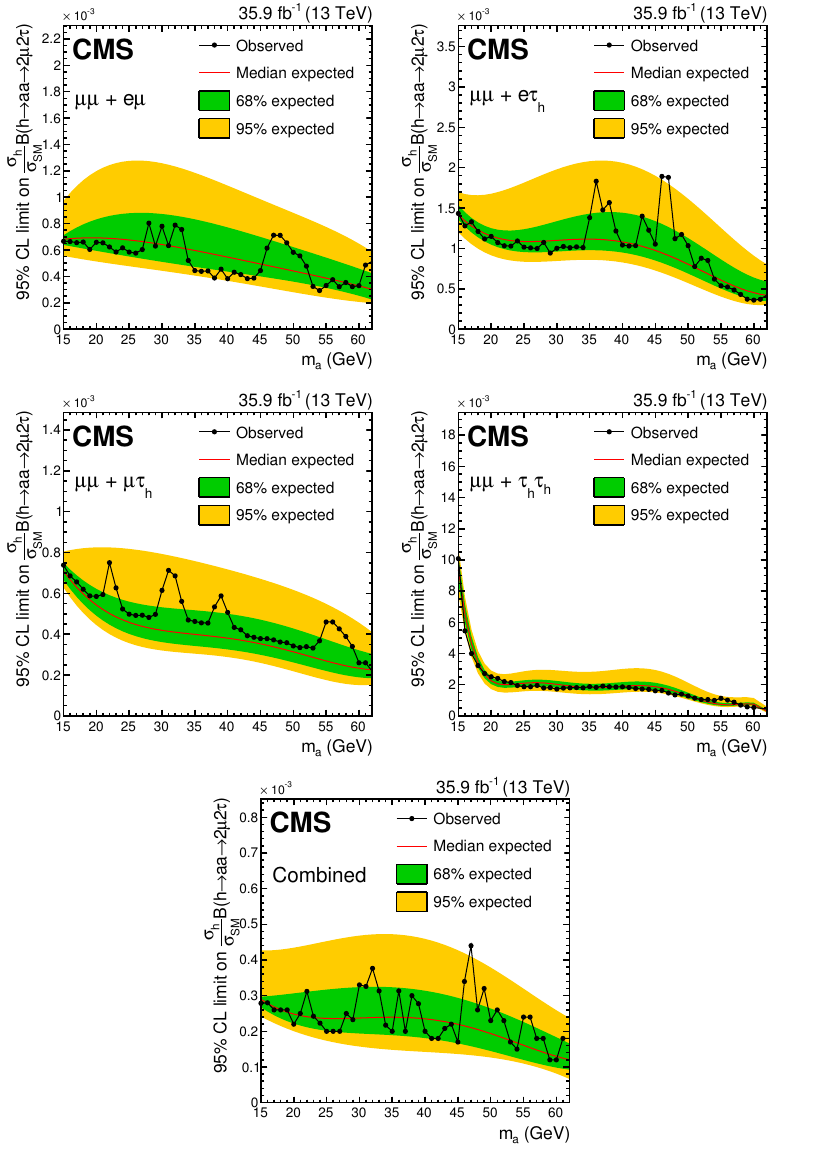
Figure 4 . Upper limits at 95% CL on ( (cid:27) h =(cid:27) SM ) B (h ! aa ! 2 (cid:22) 2 (cid:28) ), in the (cid:22)(cid:22) + e (cid:22) (upper left), (cid:22)(cid:22) + e (cid:28) h (upper right), (cid:22)(cid:22) + (cid:22)(cid:28) h (middle left), (cid:22)(cid:22) + (cid:28) h (cid:28) h (middle right) (cid:12)nal states, and for the combination of these (cid:12)nal states (lower). The h ! aa ! 4 (cid:28) process is considered as a part of the signal, and is scaled with respect to the h ! aa ! 2 (cid:22) 2 (cid:28) signal using eq. (1.1).